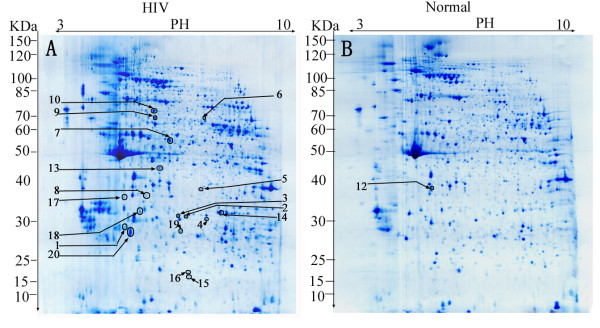
CBB-stained 2-DE gels of HIV-positive (A) and healthy donors (B). Each sample (1000 μg) was subjected to 2DE and CBB staining. Molecular weight of markers is shown on the left. The identified differential proteins (p < 0.05) were marked in gels. Proteins up-regulated in HIV/AIDS were marked in Figure 1A, that down-regulated in Figure 1B.